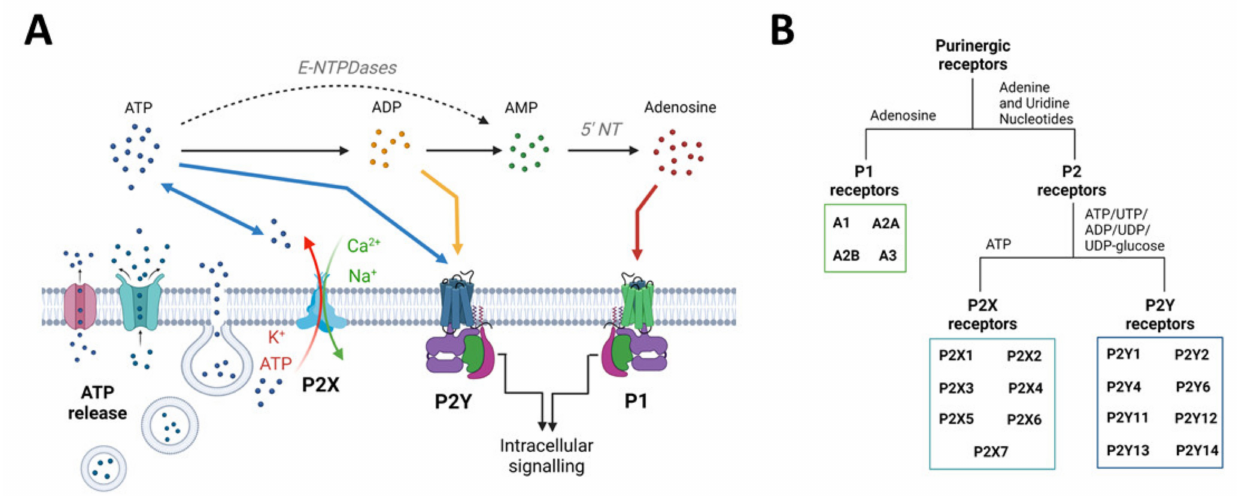
Figure 2. Purinergic signalling overview: from ATP release mechanisms to ATP receptors. ( A ) ATP can be released from neurons and glia via transporters, membrane channels, and exocytosis. ATP can also be released via P2X7 channels (P2X7R). Once released, ATP is converted into adenosine through the intermediates ADP and AMP via ectoenzymes such as NTPDases, NPPases, and alkaline phosphatase. Extracellular ATP can act on P2X (ligand gated) and P2Y (G protein coupled) receptors. ADP, the first breakdown product, can also act via certain subtypes of P2Y receptors. Adenosine acts via P1 (G protein coupled) receptors. ( B ) Schematic overview of purinergic receptors is divided into adenosine-sensitive P1 receptors, which are further subdivided into A 1 , A 2A , A 2B , and A 3 receptors, and nucleotide-sensitive P2 receptors, which are divided into inotropic P2X and metabotropic P2Y receptors. There are seven mammalian P2X receptor subtypes, which all respond to ATP. The eight to date identified P2Y receptor subtypes respond to ATP, ADP, UTP, UDP, or UDP-glucose, depending on the subtype. Created with BioRender.com (accessed on 17 February